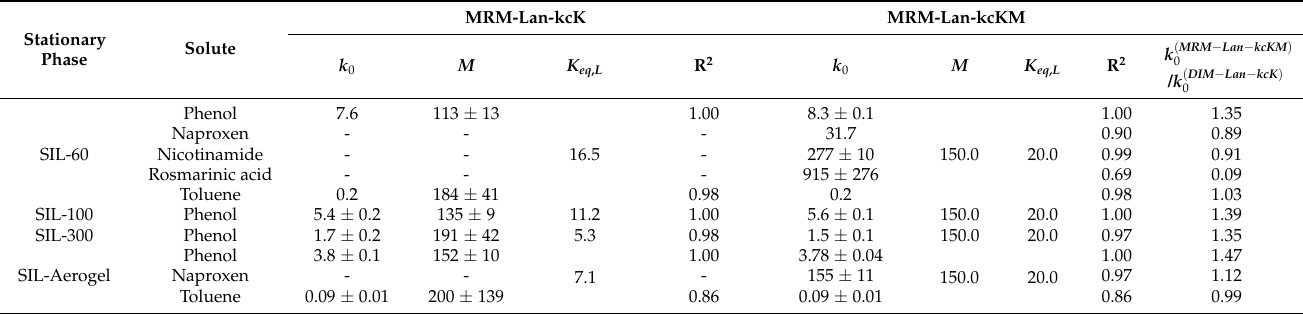
Table 5. Regression results for